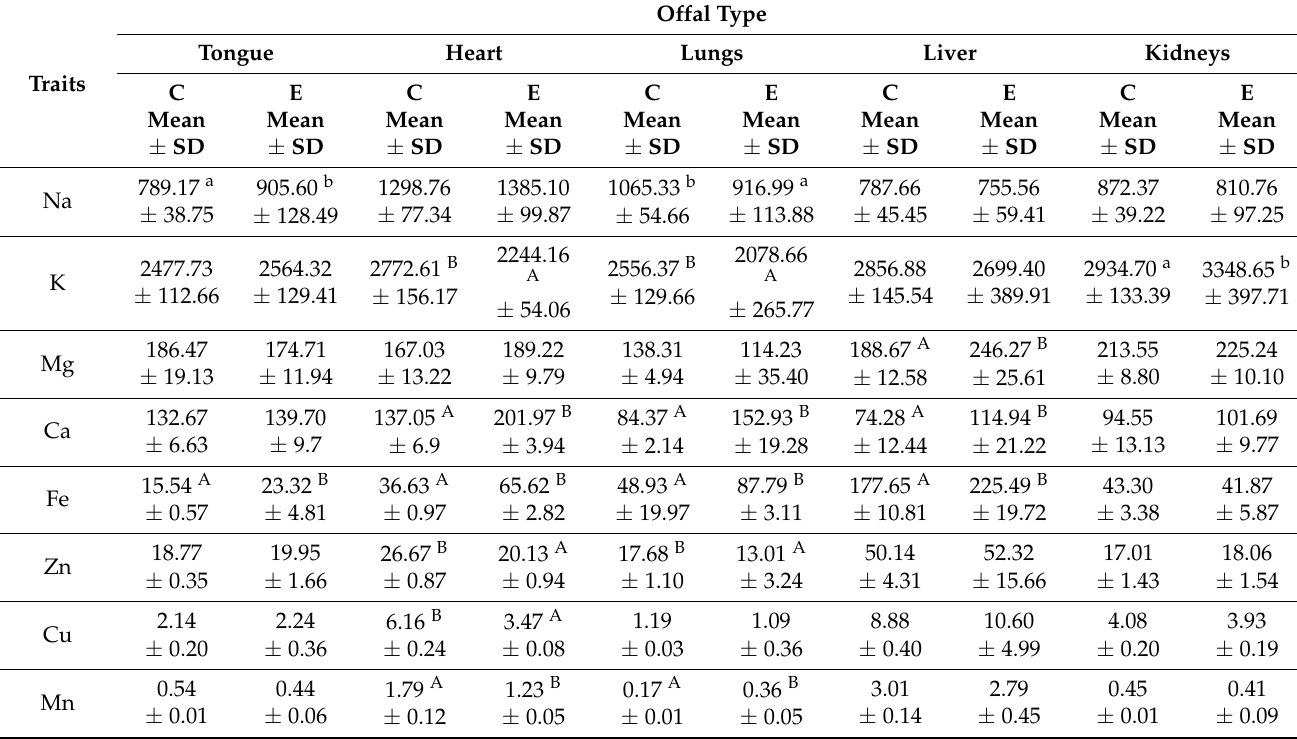
Table 8. Mineral content (mg · kg − 1 ) of the